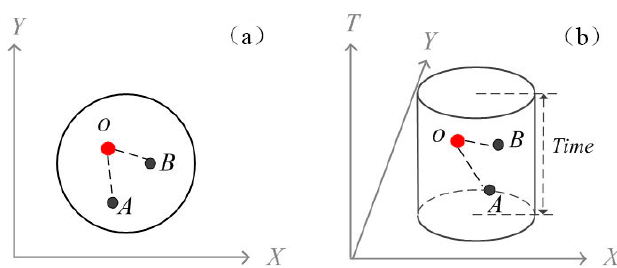
Figure 2. Illustration of spatial field and spatiotemporal field. ( a ) The neighbourhood in spatial data field and ( b ) The neighbourhood in spatiotemporal data field.